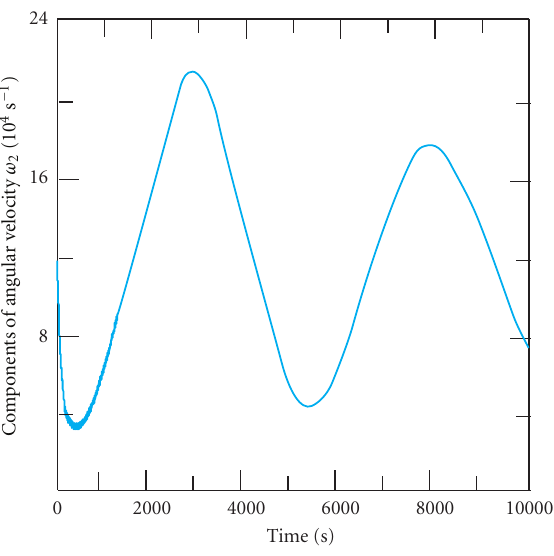
Figure 18: Angles of damping gyros deviations versus